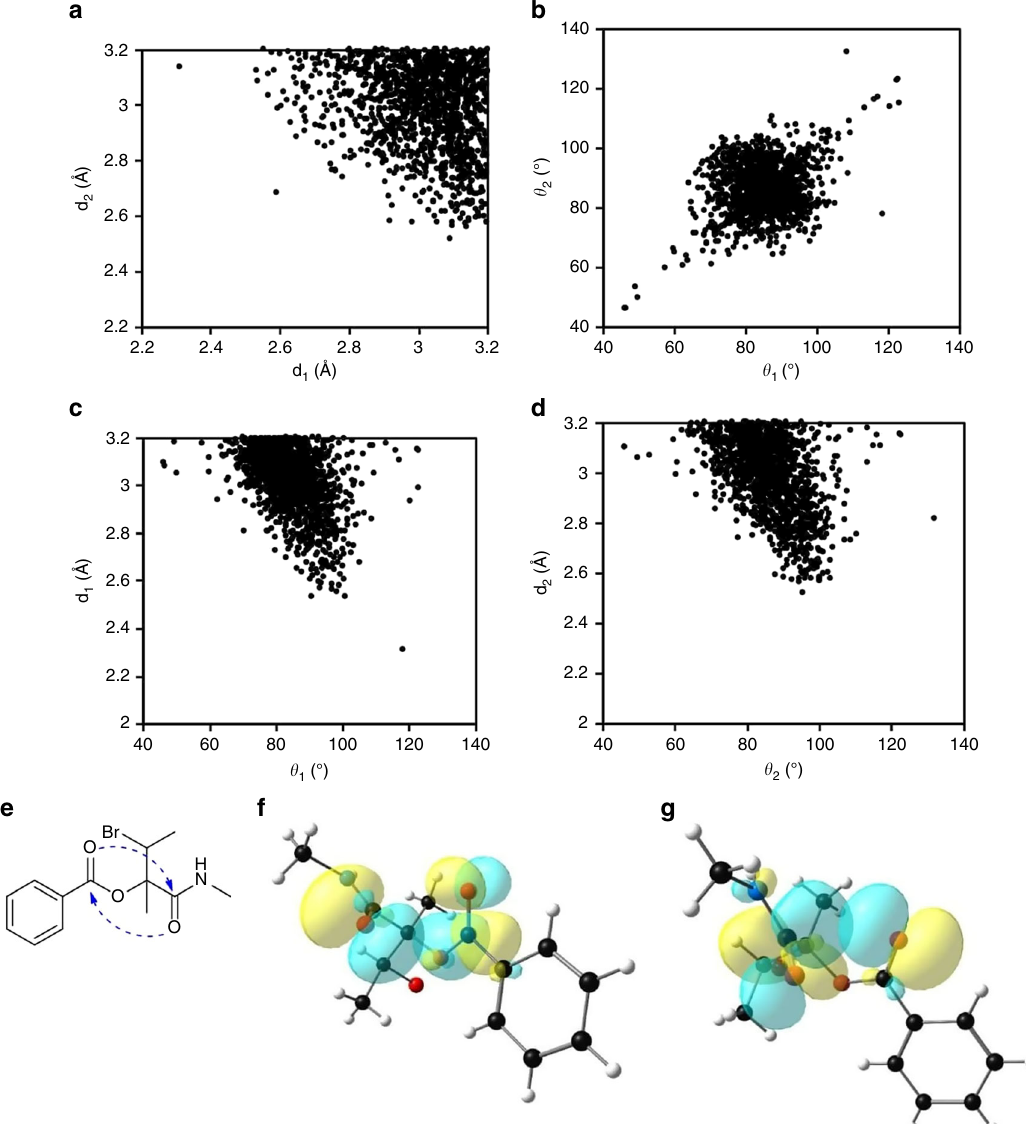
Fig. 3 X-ray crystallographic data and NBO overlap diagrams for CSD molecules. a Plot showing the distribution of O ··· C distances (d 1 and d 2 ) in molecules obtained from the CSD search. b Plot showing the distribution of ∠ O ··· C = O angles ( θ 1 and θ 2 ) in molecules obtained from the CSD search. c Plot of distance d 1 vs. angle θ 1 in molecules obtained from the CSD search. d Plot of distance d 2 vs. angle θ 2 in molecules obtained from the CSD search. e Chemical structure of a molecule (CCDC reference code: JUHQEK) obtained from the CSD search. The amide carbonyl group is taken as CO-I and the ester carbonyl group is taken as CO-II here. f NBO orbital overlap between oxygen lone pair ( n O ) of CO-I and π * C = O orbital of CO-II of JUHQEK. g NBO orbital overlap between oxygen lone pair ( n O ) of CO-II and π * C = O orbital of CO-I of JUHQEK. [d 1 = O 2 ··· C 5 ; d 2 = O 6 ··· C 1 ; θ 1 = ∠ O 2 ··· C 5 = O 6 ; θ = ∠ O 6 ··· C 1 = O 2 (Supplementary Fig. 3)]. Curved dotted arrows indicate n → π * 2